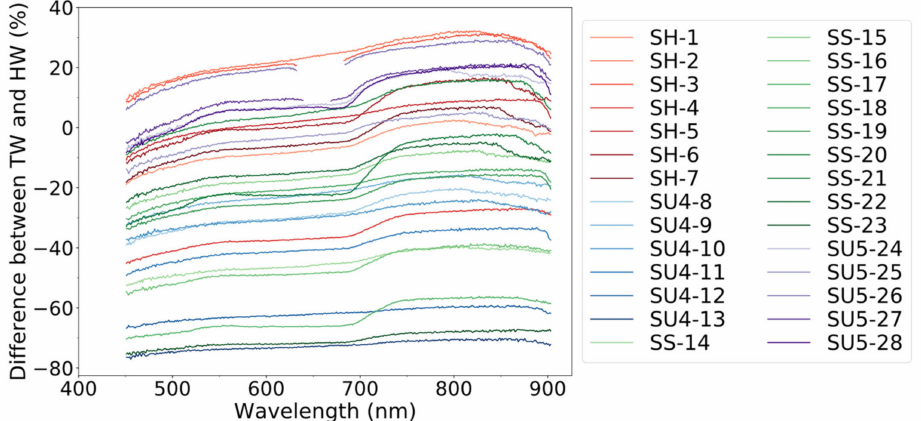
Figure 5. Difference between the horizontal and at-target white reference reflected radiance for each sample and light growth treatment, i.e., shade-adapted (SH), sun-adapted (SU) and intermediate half sun and half shaded adapted beech saplings.